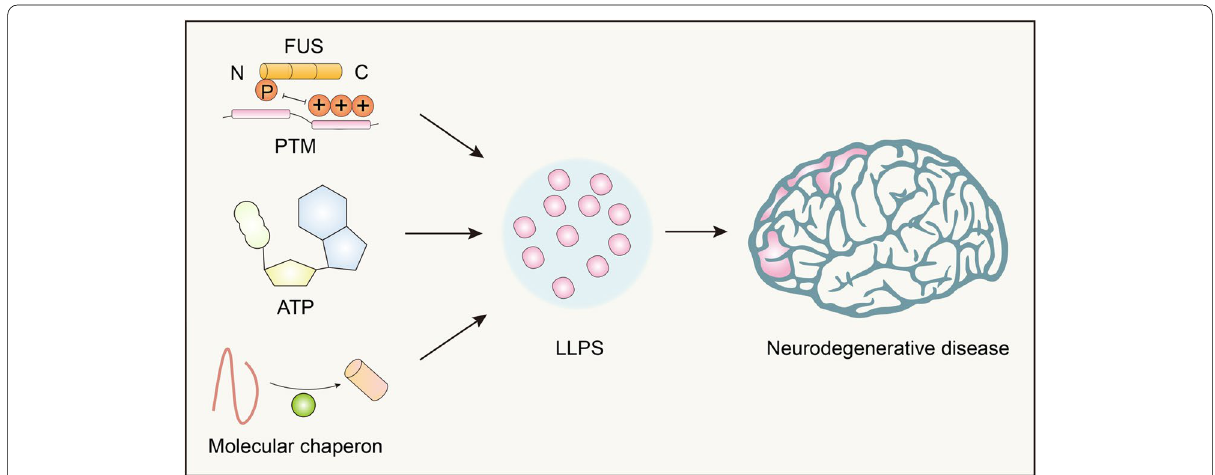
Fig. 8 Factors in regulating LLPS-induced neurodegenerative diseases. Neurodegenerative disease such as amyotrophic lateral sclerosis, Parkinson’s disease, and Alzheimer’s disease are reported to be controlled by LLPS. Different circumstances are important in regulating this process. The PTM, specifically speaking, the phosphorylation of FUS enhances its LLPS. Chaperon such as HSP70 promotes the misfolding and subsequent LLPS of α-synuclein. Aging leads to a decrease in ATP levels, which reduces the reversibility of cellular